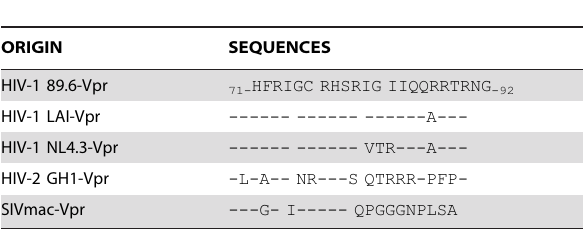
Table 3. Amino acid sequence alignement of Vpr proteins from different origins in the vicinity of mitochondriotoxic and PP2A-dependent death domains.